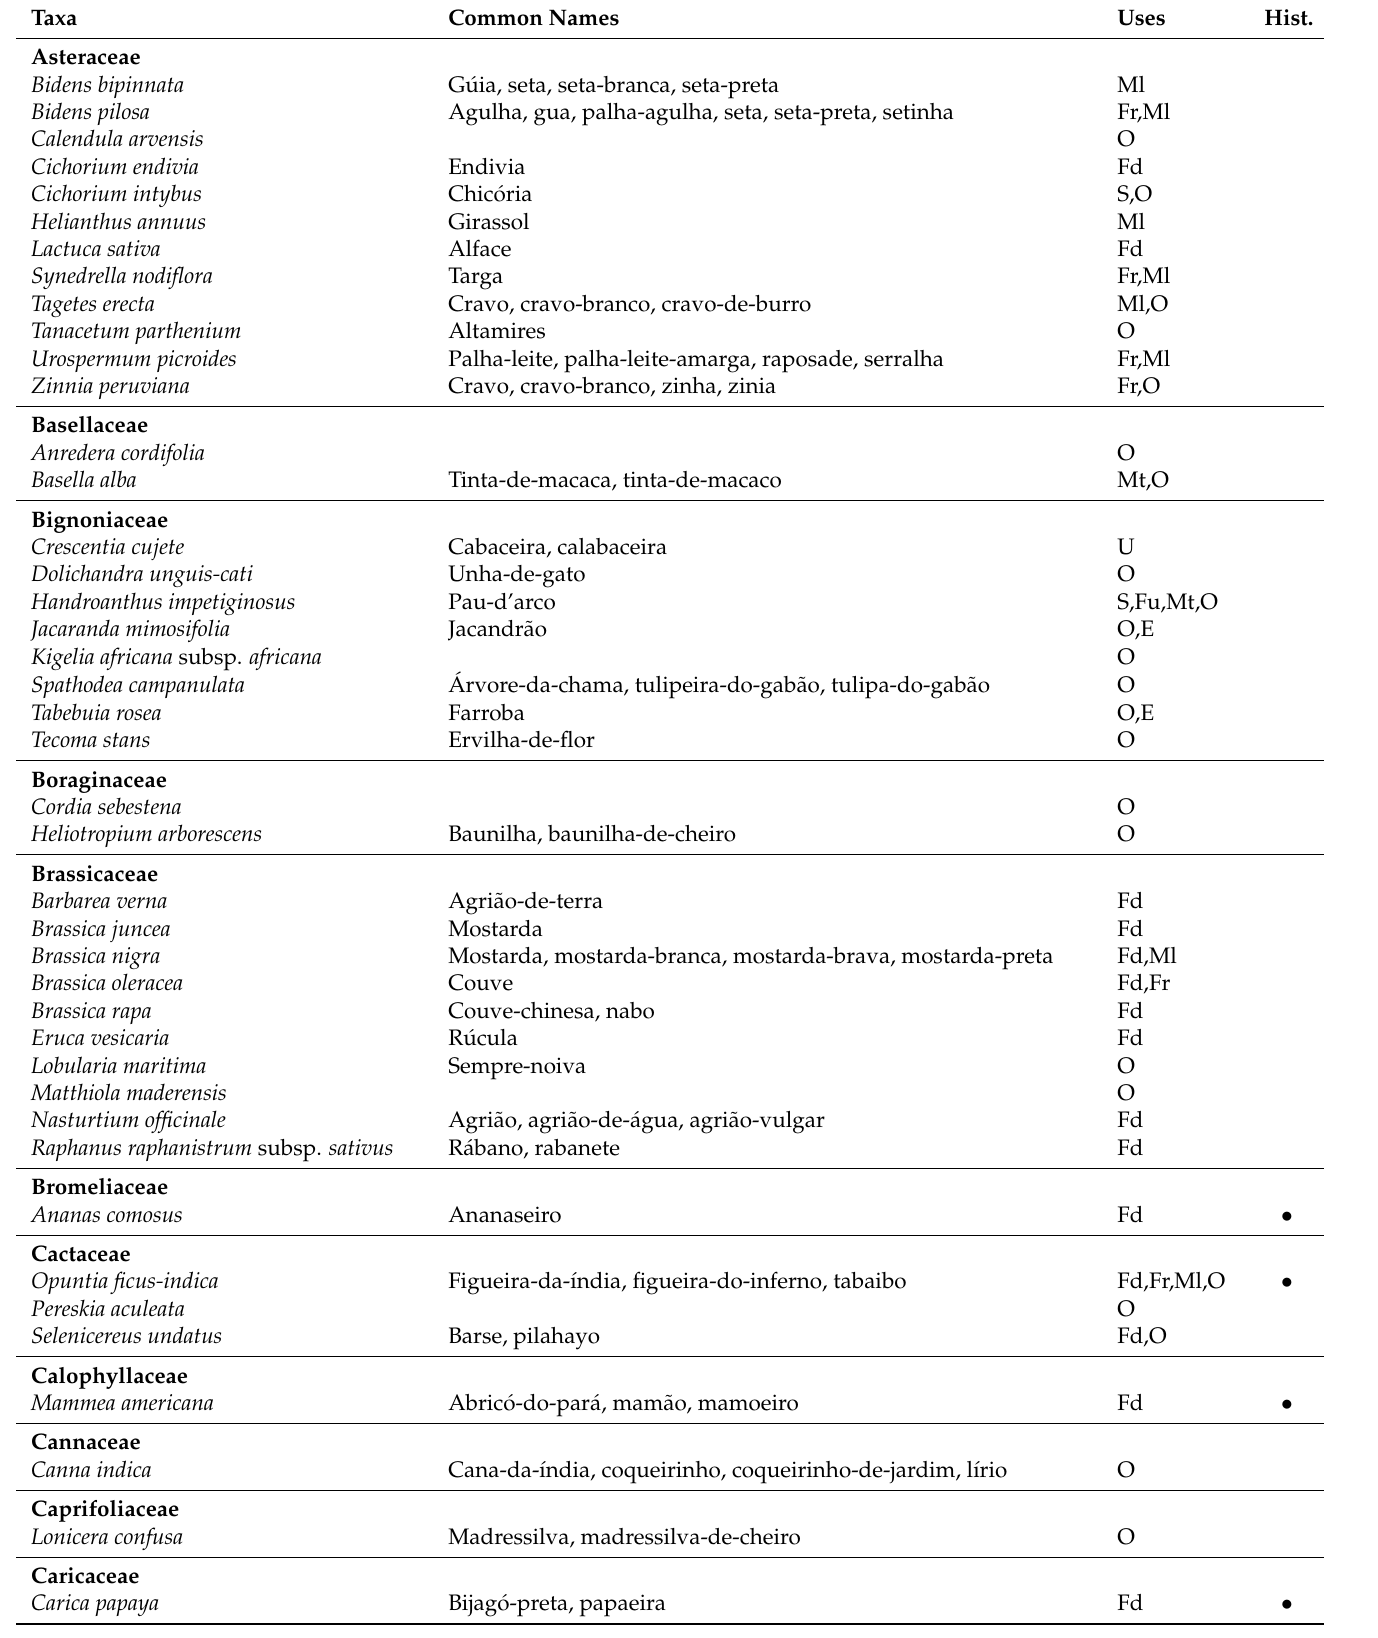
Figueira-da- í ndia, figueira-do-inferno,